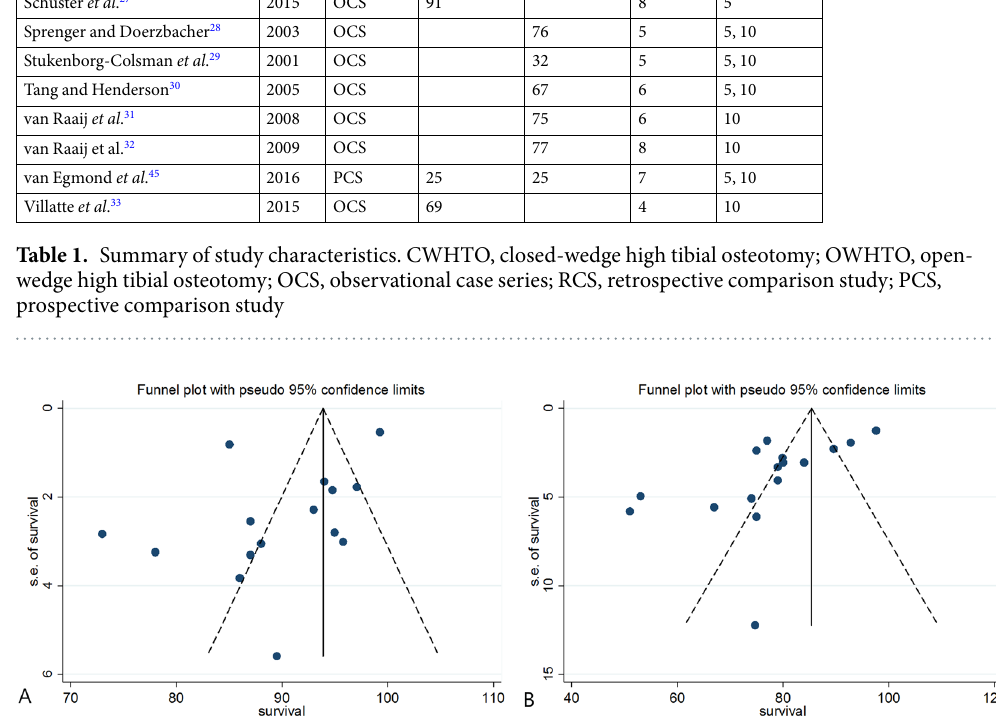
Midterm survival rate. Of the 23 studies, six included 578 knees that underwent medial opening wedge HTO and described the survival rate at 5 years after surgery, and 15 included 2084 knees that underwent lateral closing wedge osteotomy and described the survival rate at 5 years after surgery. The pooled 5-year survival rates were 95.1% ( 95% CI: 93.1 to 97.1%) in open wedge HTO and 93.9% (95% CI: 93.1 to 94.6%) in closed wedge HTO, respectively (Fig. 3A and B). However, although there was a 1.2% greater survival rate in open wedge HTOs than in closed wedge HTOs, this difference did not reach statistical significance ( P = 0.419). Long-term survival rate. Of the 23 studies, five included 467 knees that underwent medial opening wedge HTOs and described the survival rate at 10 years after surgery, and 16 included 2496 knees that underwent lateral closing wedge osteotomy and described the survival rate at 10 years after surgery. The pooled 10-year survival rates were 91.6% ( 95% CI: 88.5 to 94.8%) in open wedge HTOs and 85.4% (95% CI: 84.0 to 86.7%) in closed wedge HTOs, respectively, indicating that open wedge HTOs had 6.2% greater survival rate at 10 years after sur- gery than did closed wedge HTOs ( P = 0.002, Fig. 4A and B).